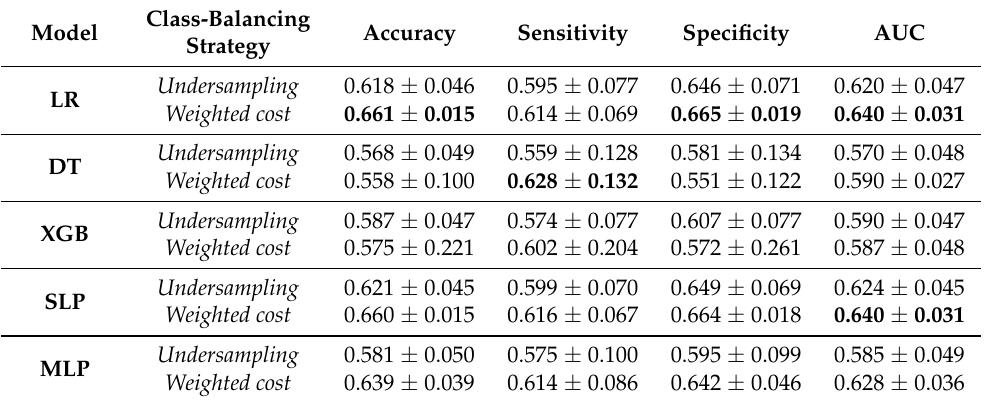
Table 1. Mean ± standard deviation of the performance (accuracy, sensitivity, specificity, AUC) on 50 test sets when training different ML models using two class-balancing strategies. The highest average performance for each figure of merit is in